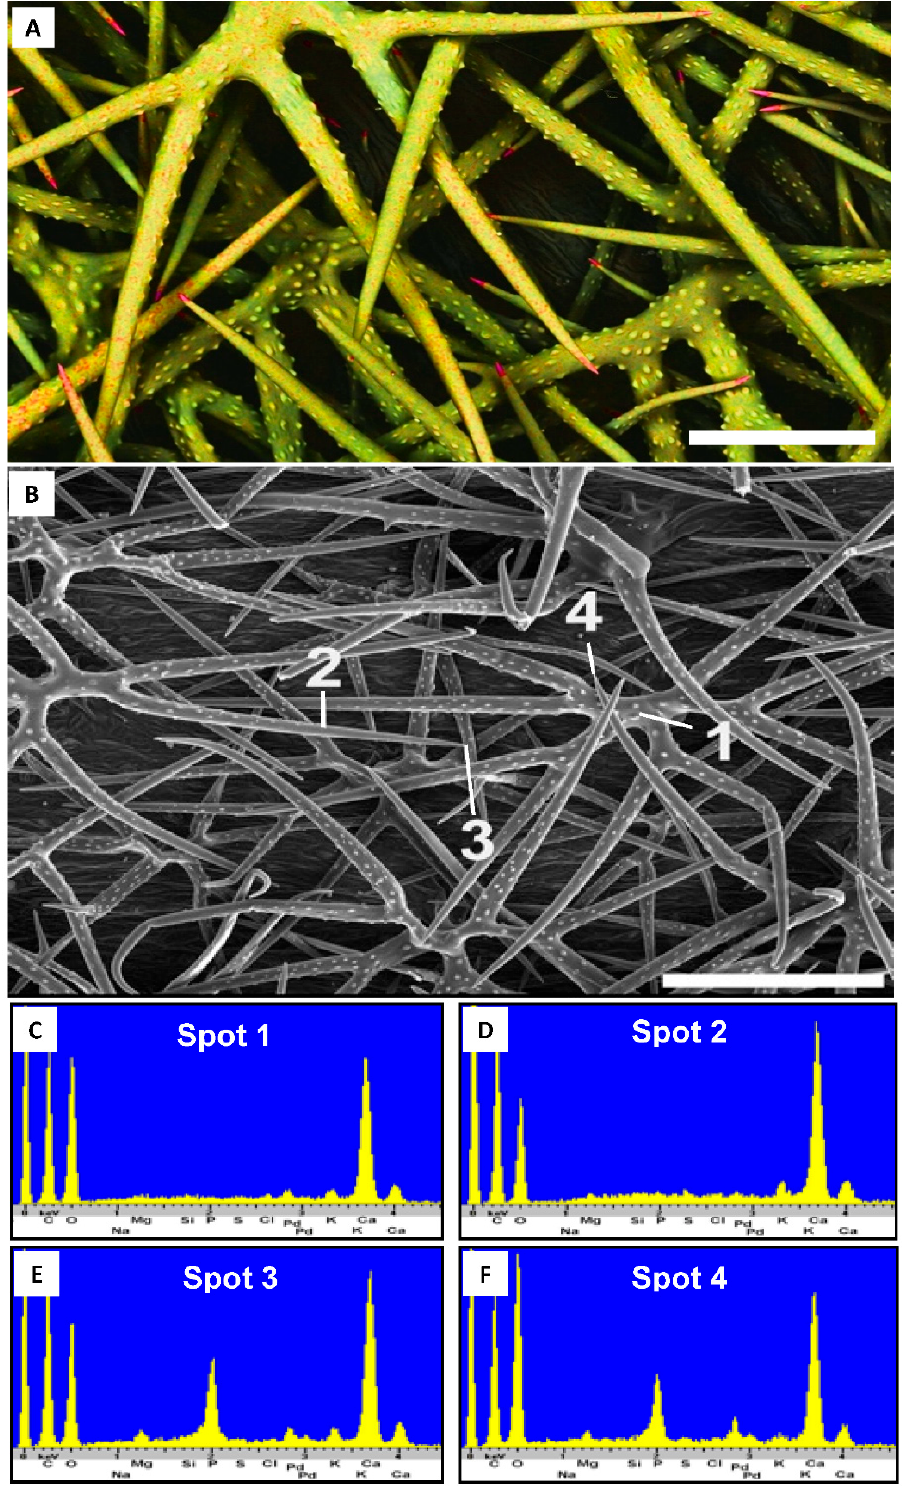
Figure 2. Trichome of Fibigia clypeata ( Selvi , FI-058623, FI). ( A ). Secondary electron image depicting small tip regions containing phosphorus in high concentrations as calcium phosphate; depicted by red color. ( B ). Secondary electron image with analyzed spots associated with energy-dispersive X-ray spectroscopy spectra in ( C ) (base), ( D ) (shaft), ( E ) (tip) and ( F ) (tip). Scale bars: ( A ), 200 µ m; ( B ), 100 µ